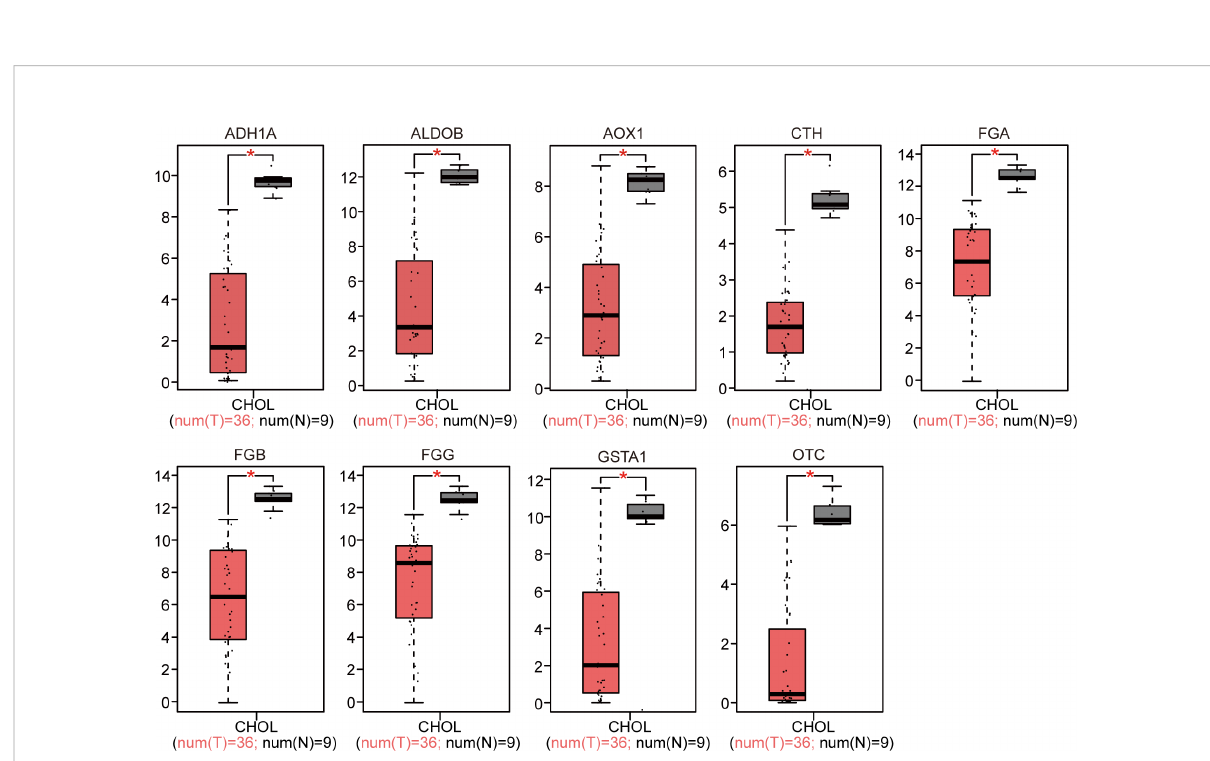
FIGURE 5 GEPIA website-based veri fi cation of the expression of nine downregulated genes associated with poor prognosis (*P <